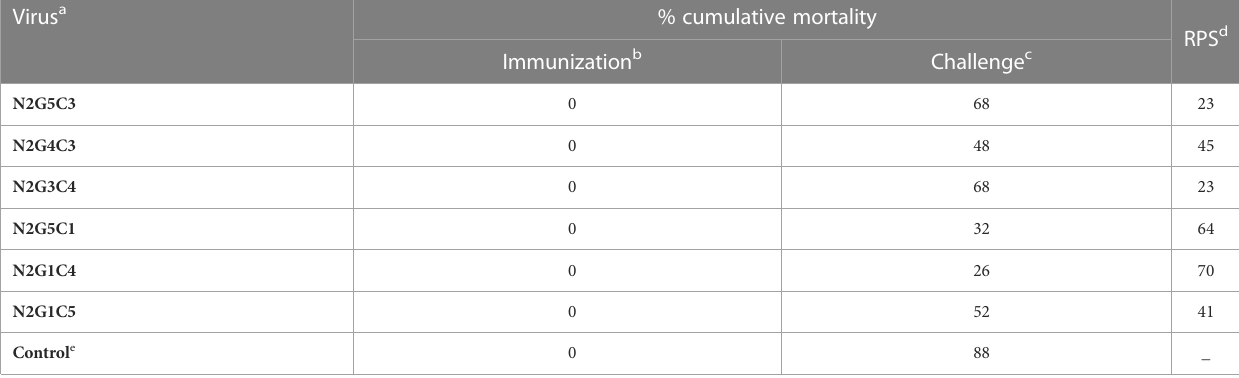
TABLE 2 Summary of percent cumulative mortality observed in sole injected with rVHSVGO-LinkerP2NNV and challenged by NNV. Virus a % cumulative mortality